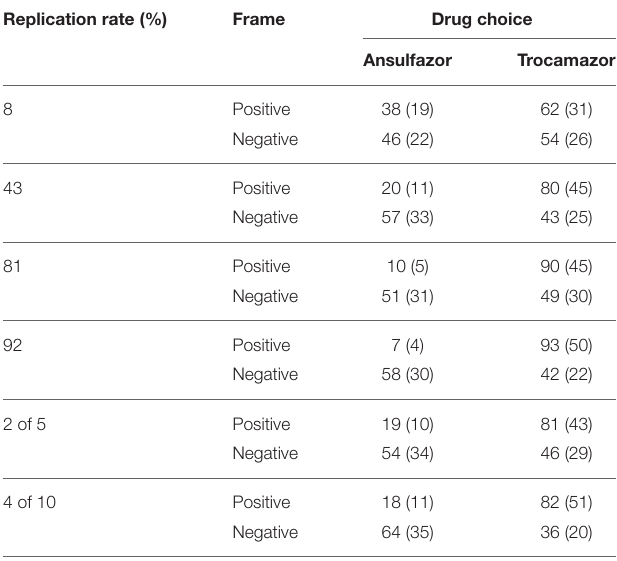
TABLE 8 | Descriptive statistics for Experiment 5: percentage of sample favoring each drug as a function of replication rate and frame. Replication rate (%)